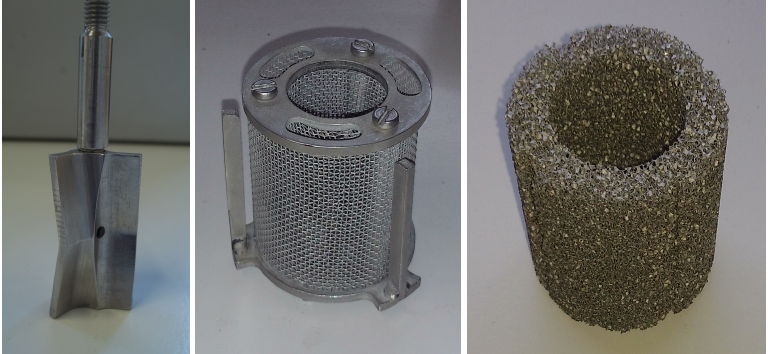
Figure 1. Experimental device. From left to right: gas-inducing impeller, basket, and foam